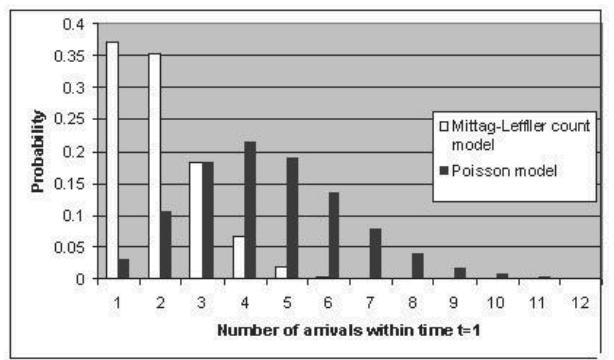
Figure 5 – Probability histogram of the predicted number of customers arriving in a bank according to Mittag-Leffler count model and Posson